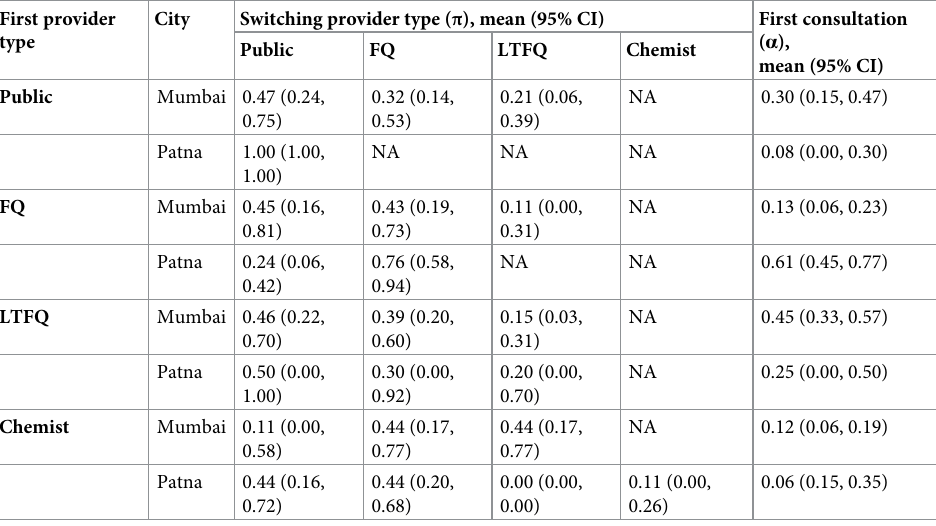
Table 5. Probabilities of first consultation and probability of switching across provider